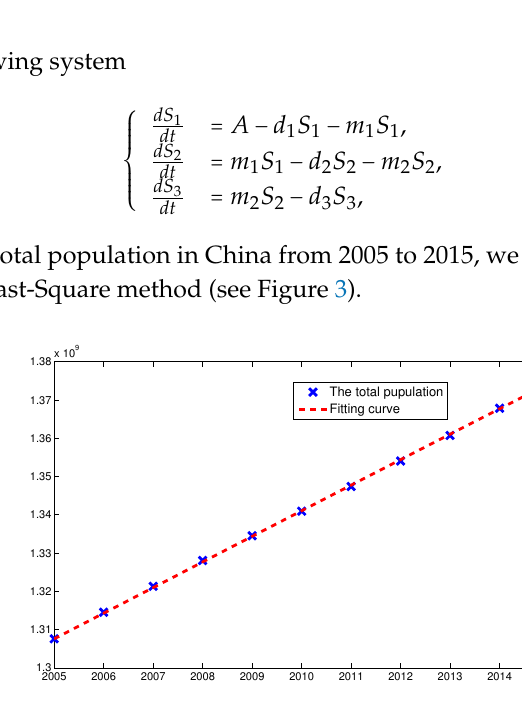
Figure 3. The fitting curve of parameters m 1 and m 2 by L-S method using the total population from 2005 to 2015. The blue cross point and red dashed line represent the total number of population and the fitted curve, respectively.